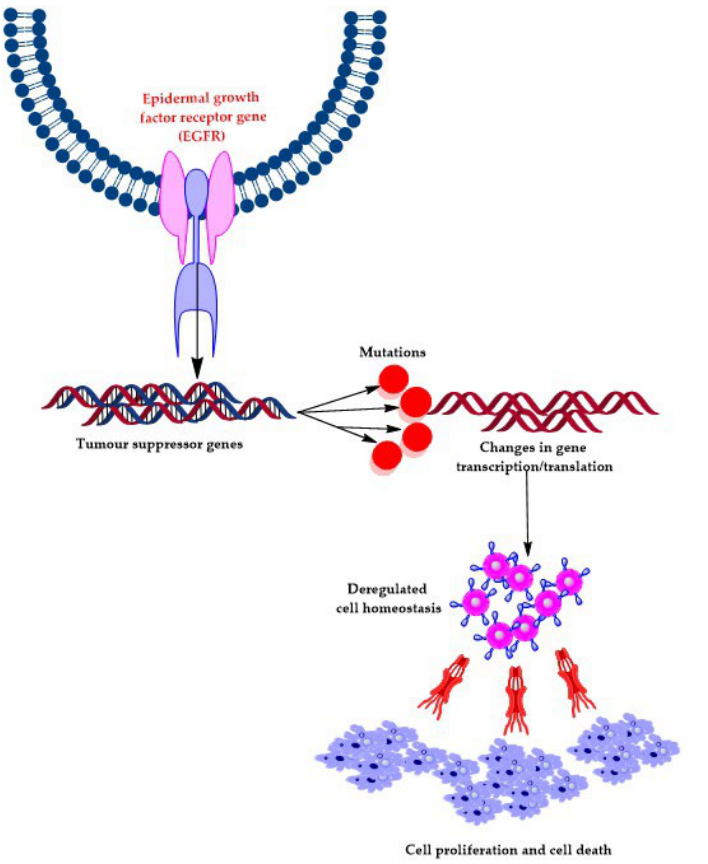
Figure 1. Mutations in EGFR cause breast cancer.